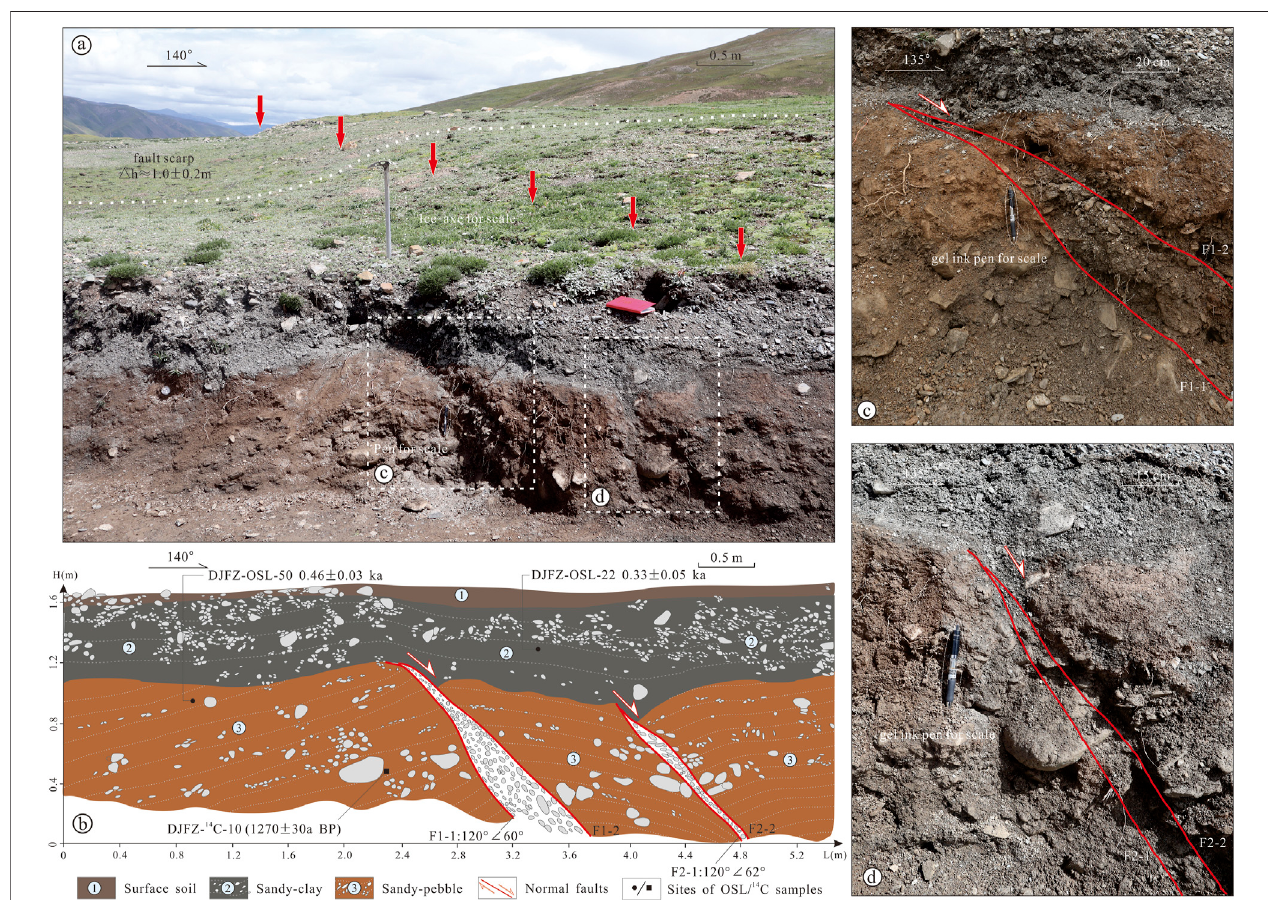
FIGURE 7 | East wall logs of the trench excavated near Riqing village, and the site of the trench is marked in Figure 3 W. (A) Tectonic geomorphic features of the DJFnearRiqingvillage.RedarrowsinthemapdelineatethelatestsurfacerupturetraceoftheDJFwithaheightof1.0±0.2 m.Notetheice-axeinthemapforscale.The lateralwallpro fi leofthemoderngullycleanedbymanualworkinthe fi eldshowsthelatestactivecharacteristicsofthefault; (B) Interpretationmapofthelateralwallpro fi le of the modern gully cleaned. Faults F1-1, F1-2, F2-1, and F2-2 cut the sediments of Units three to two and are overlain by Unit 1 (see the text for details), and the accumulatedoffsetofthefaultsis~0.5 m.Thegravelinthefaultzoneiswelloriented;photos (C) and (D) areenlargedmapsof (A) .Redlinesinthemapindicate thefault traces; note the gel ink pen in the map for scale.